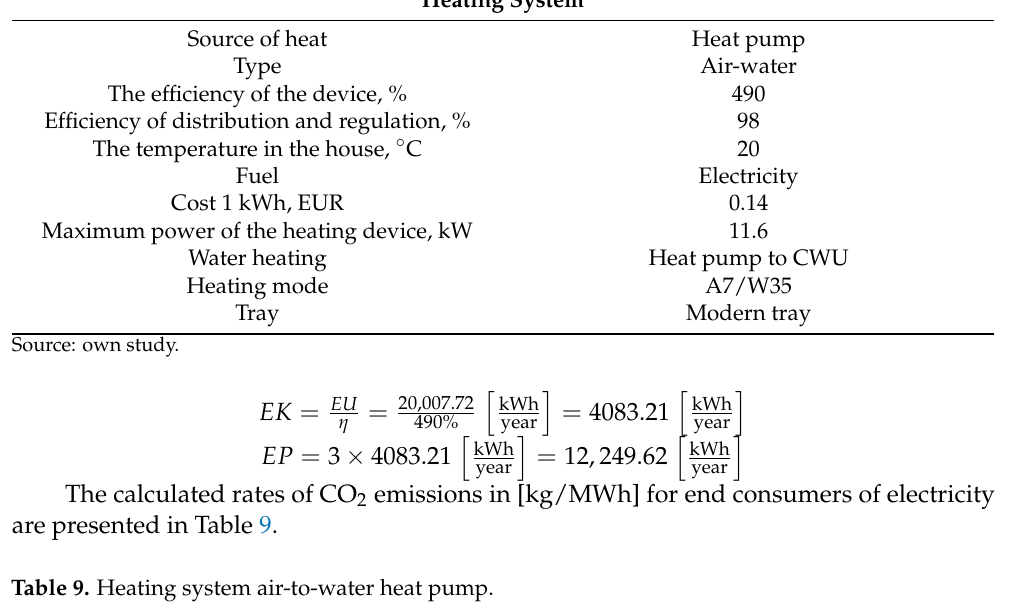
Table 8. Heating system air-to-water heat pump.